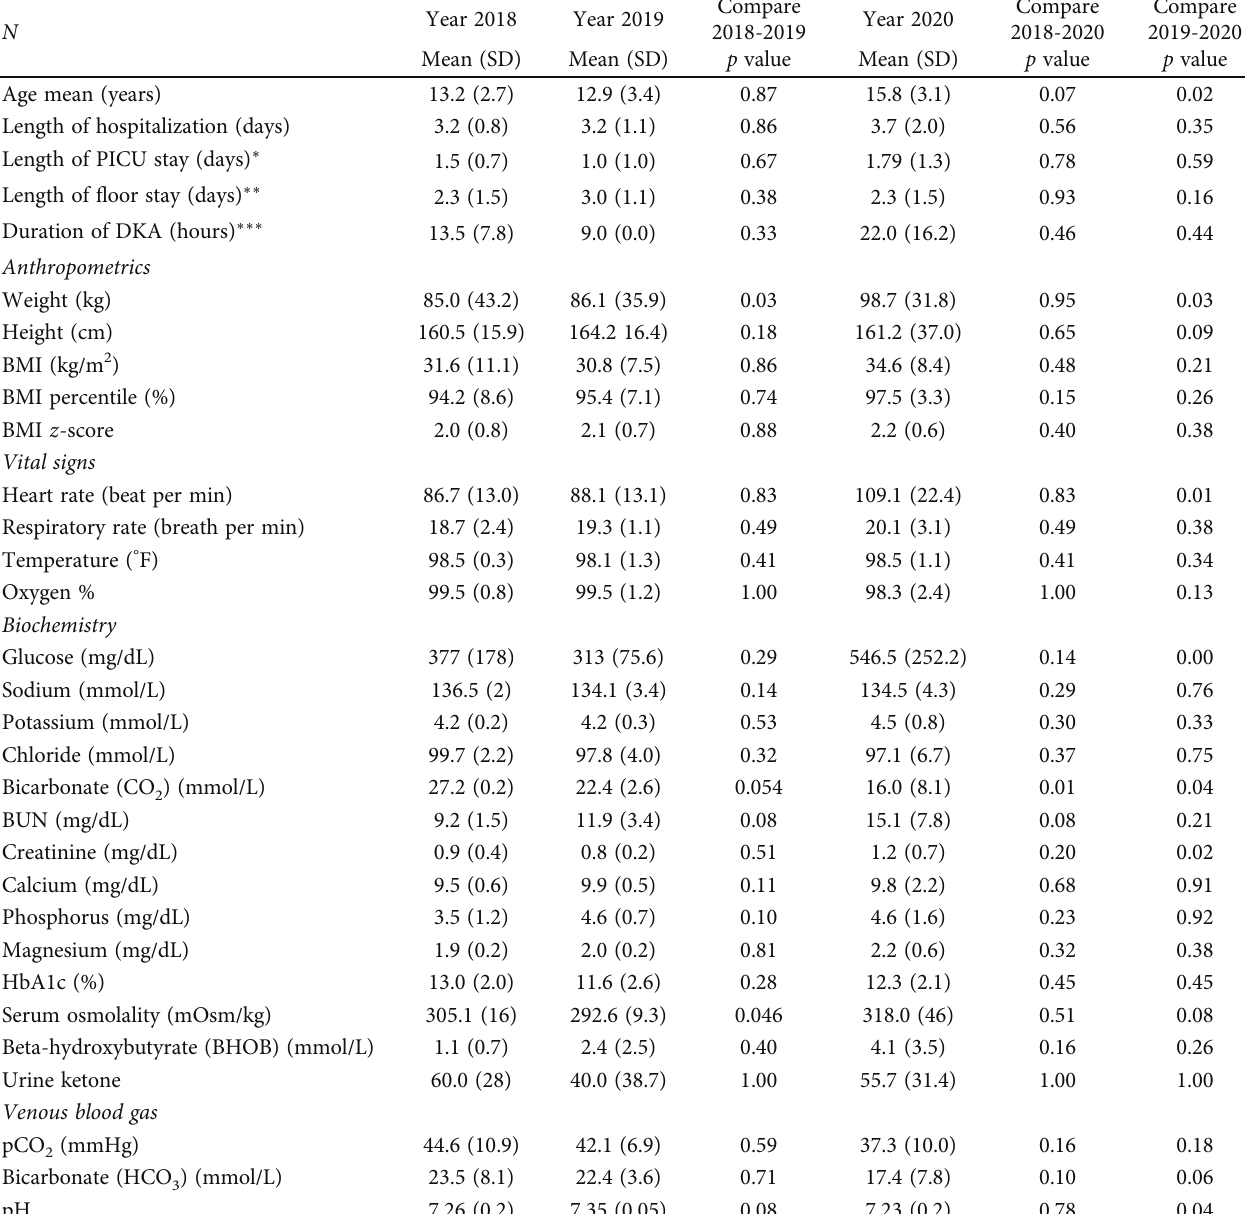
Table 5: Clinical characteristics of children and adolescents with type 2 diabetes mellitus admitted during COVID-19 pandemic.